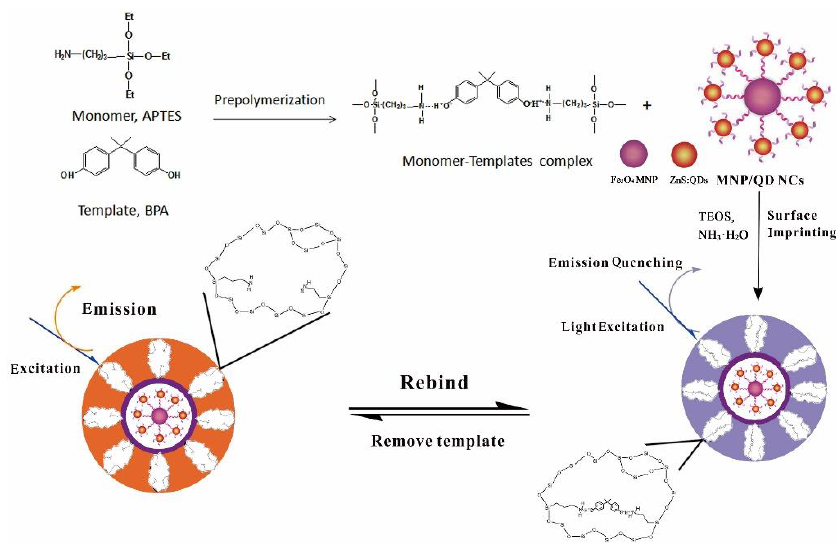
Figure 1 . Schematic illustration of the process for the fabrication of the FeO x /ZnS@MIP-based sensor. BPA: bisphenol BPA: bisphenol A.